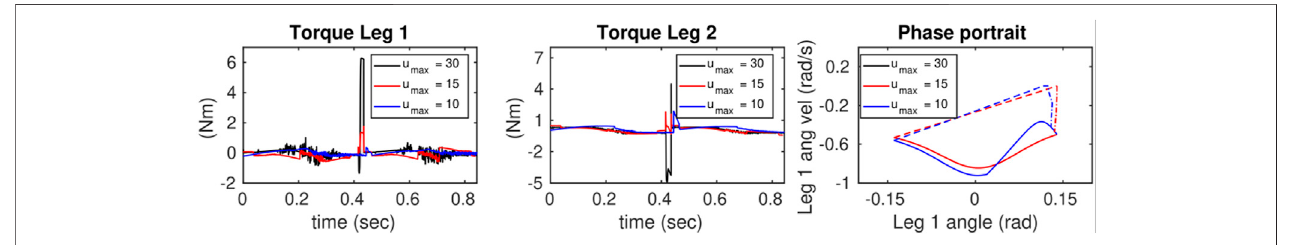
FIGURE 12 | Illustrates the reference joint angle trajectories in the 3-link